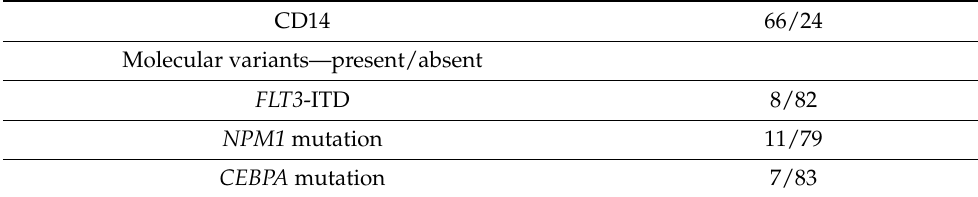
Table 1. Cont. CD14 Molecular